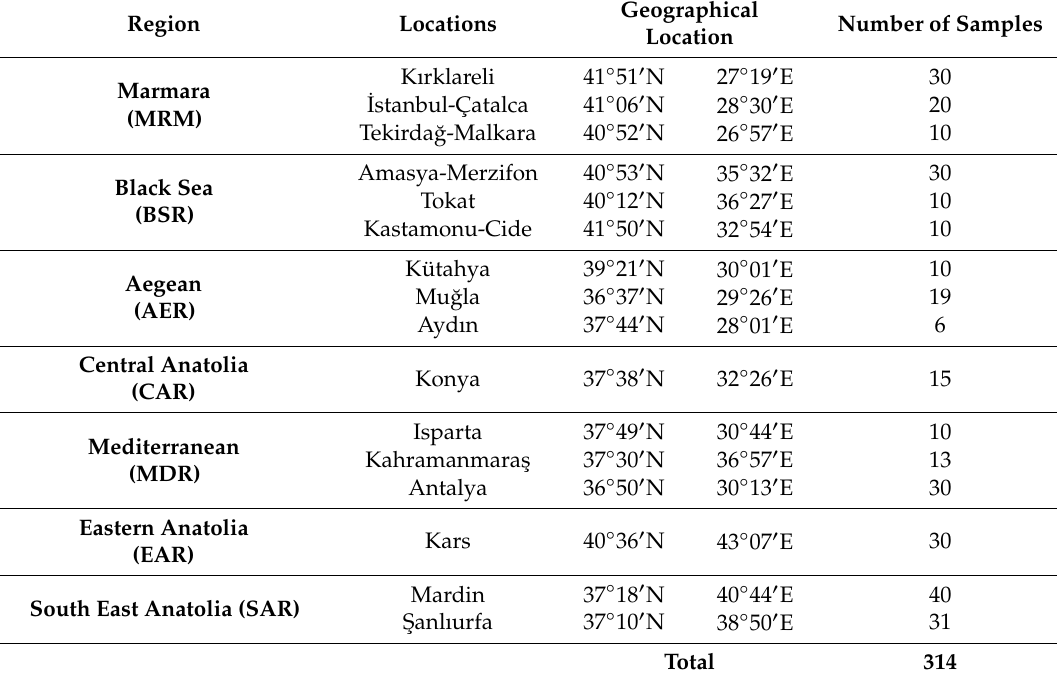
Table 1. The regions, locations, the geographical locations with the number of sample sizes.